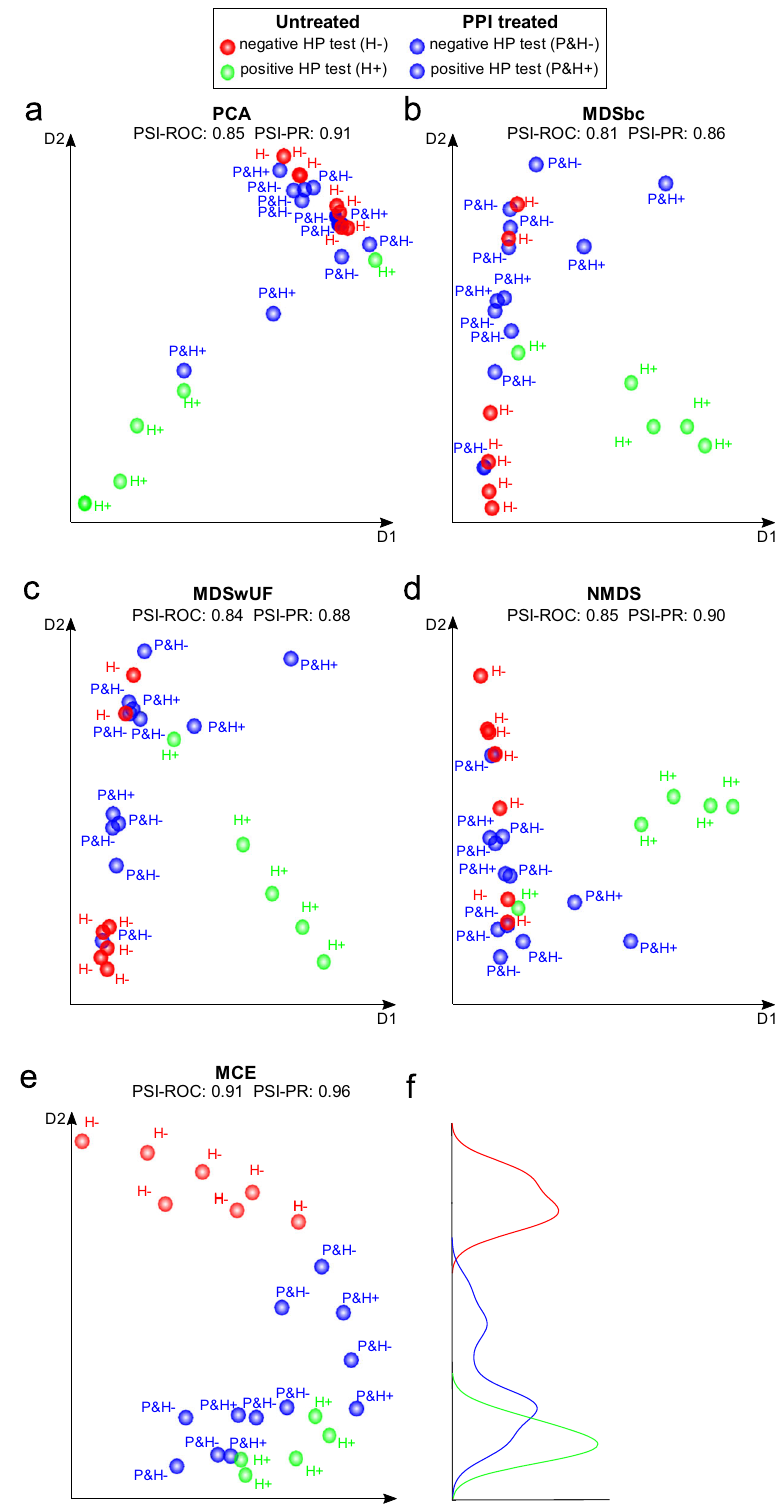
Fig. 2 Dimension reduction techniques applied to the Paroni Sterbini dataset. The plots represent the best dimension reduction results based on PSI-PR projection-based separability index (PSI) for the three different labels (P-treated, untreated H + and untreated H − ), evaluated in the 2D embedding space. Moreover, also the average values of all pairwise PSI-ROC are reported as overall estimators of separation between the groups in the 2D reduced space. a PCA; b MDS with Bray-Curtis dissimilarity (MDSbc); c MDS with weighted UniFrac distance (MDSwUF); d nonmetric MDS with Sammon Mapping (NMDS); e MCE. Blue dots represent PPI-treated samples, while red and green dots are the untreated samples which resulted either negative (red) or positive (green) to the H. pylori test (histological observation and urease test). f The curves in three different colours (red, blue and green) highlight the different distributions of the three groups on the second dimension for the MCE plot ( e